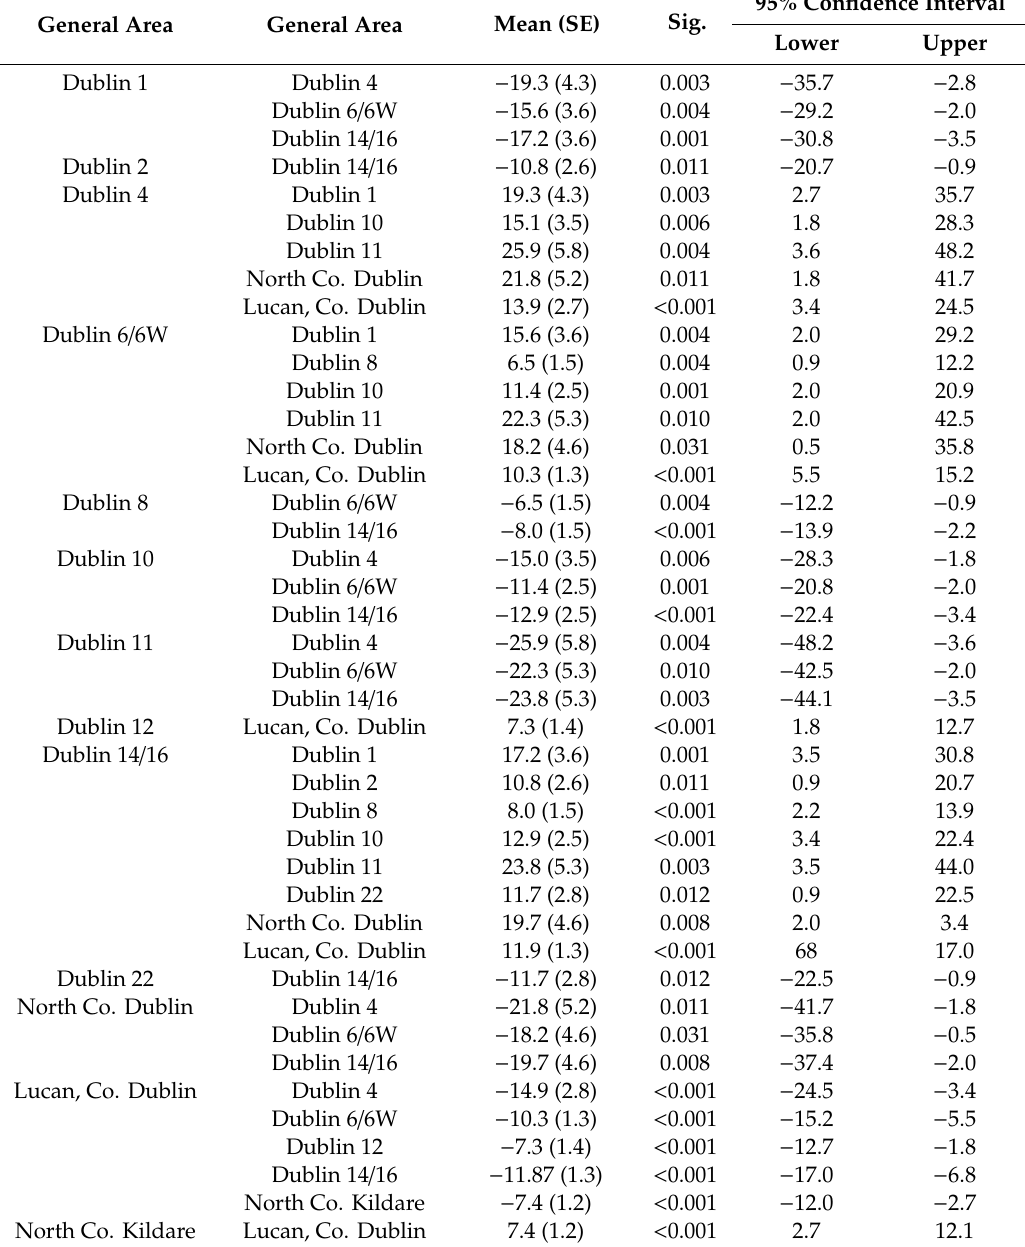
Table A1. Pairwise ANOVA